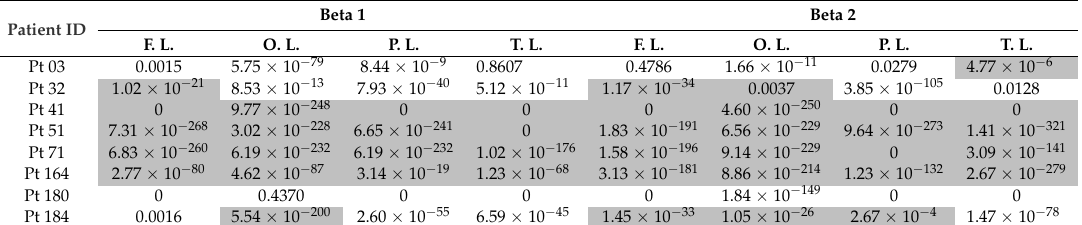
Table A3. p-values resulting from the Wilcoxon rank sum test for beta 1 and beta 2